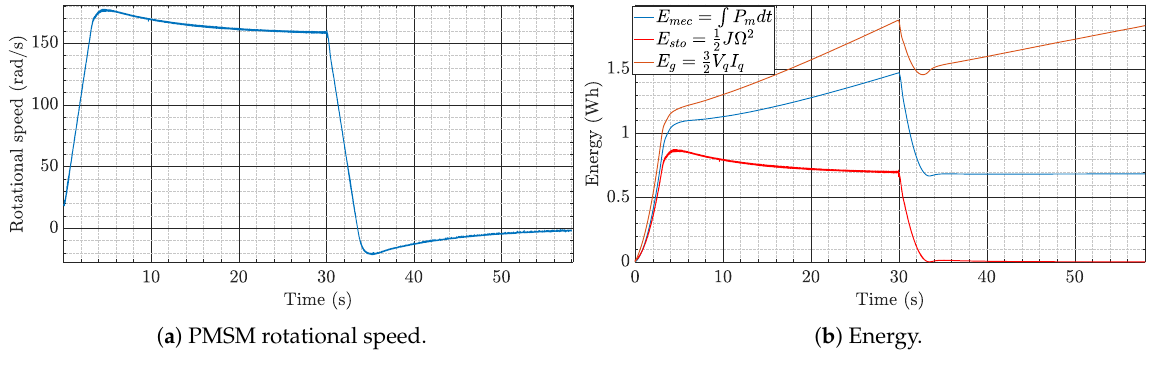
Figure 15. Energy transfer between FESS and the